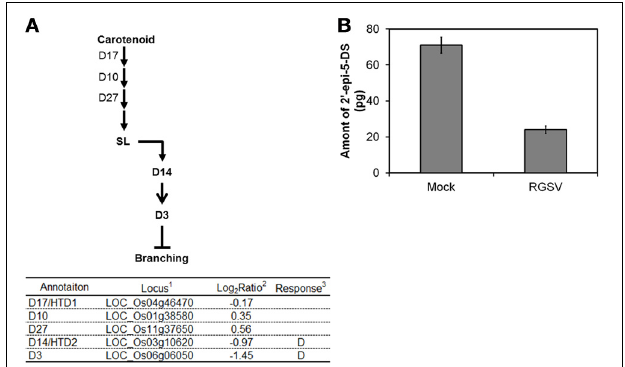
FIGURE 4 | Influence of RGSV infection on strigolactone biosynthesis and signaling. Responses of genes for (A) strigolactone metabolisms and signaling. Enzymes catalyzing reactions are shown in the table below: 1 Based on Rice Genome Annotation Project database Osa1 (rice.plantbiology.msu.edu), 2 Log 2 -based differential expression ratio (signal intensity in RTSV-infected plant/signal intensity in mock-inoculated